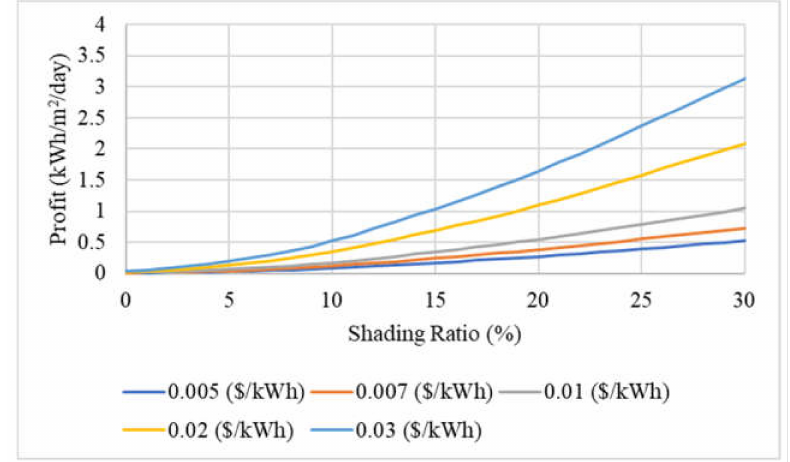
Figure 6. Profit estimation with different shading ratios.